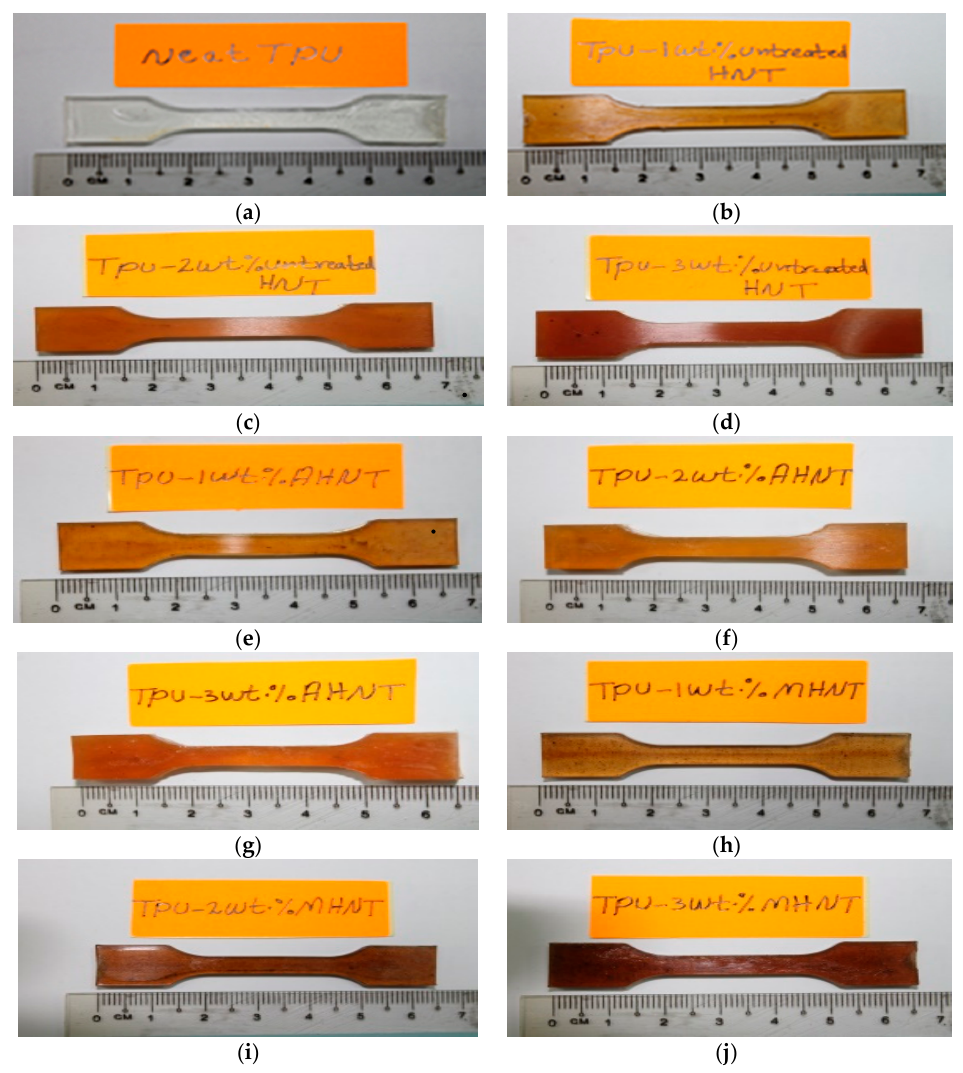
Figure 1. Samples of ( a ) thermoplastic polyurethane (TPU) matrix, ( b – d ) 1, 2, 3 wt % untreated